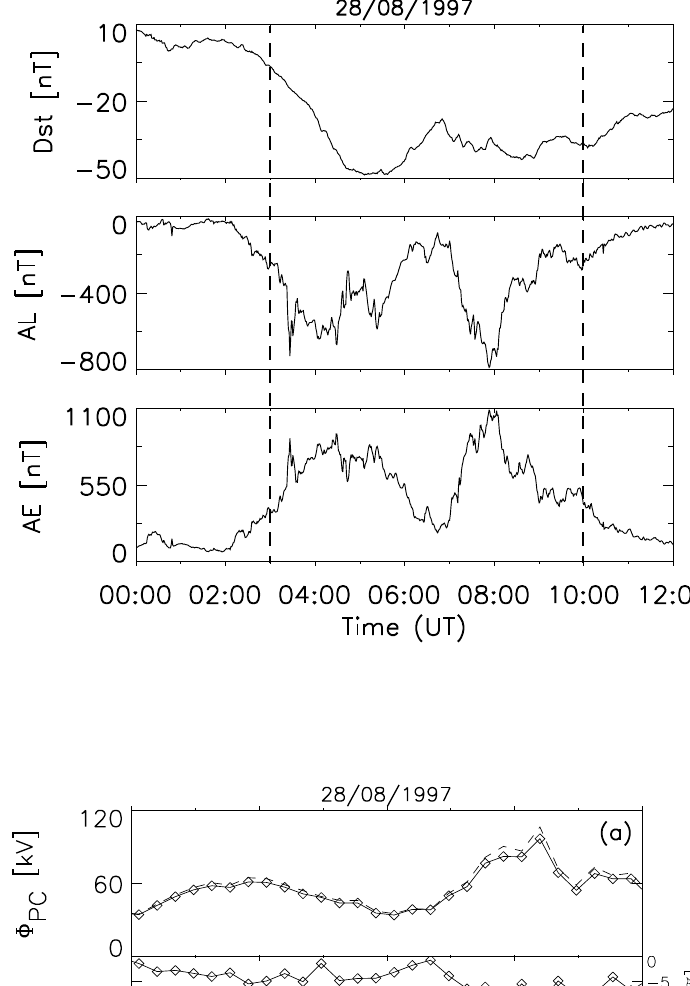
Fig. 14. (a) Polar cap potential drop 8 PC , (b) Joule heating rate Q J and (c) the ratio Q J /Q A between Joule heat- ing and energy flux estimated through- out the time interval between 03:00 and 10:00 UT on 28 August 1997. The parameters have been calculated with- out (dashed line) and with (solid line) PIXIE data. The differences in per- cent when including PIXIE measure- ments are also